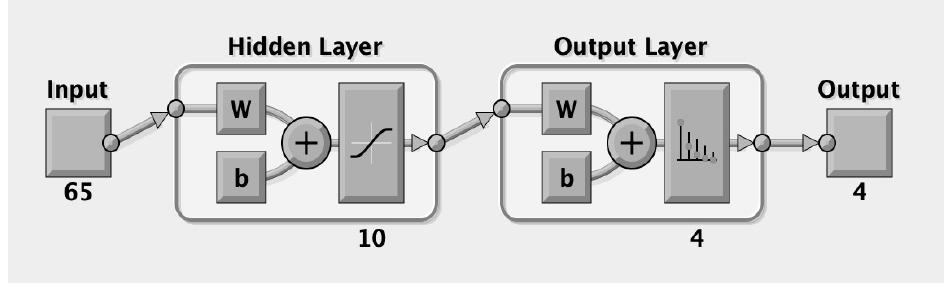
Figure 2. ANN model of this study.